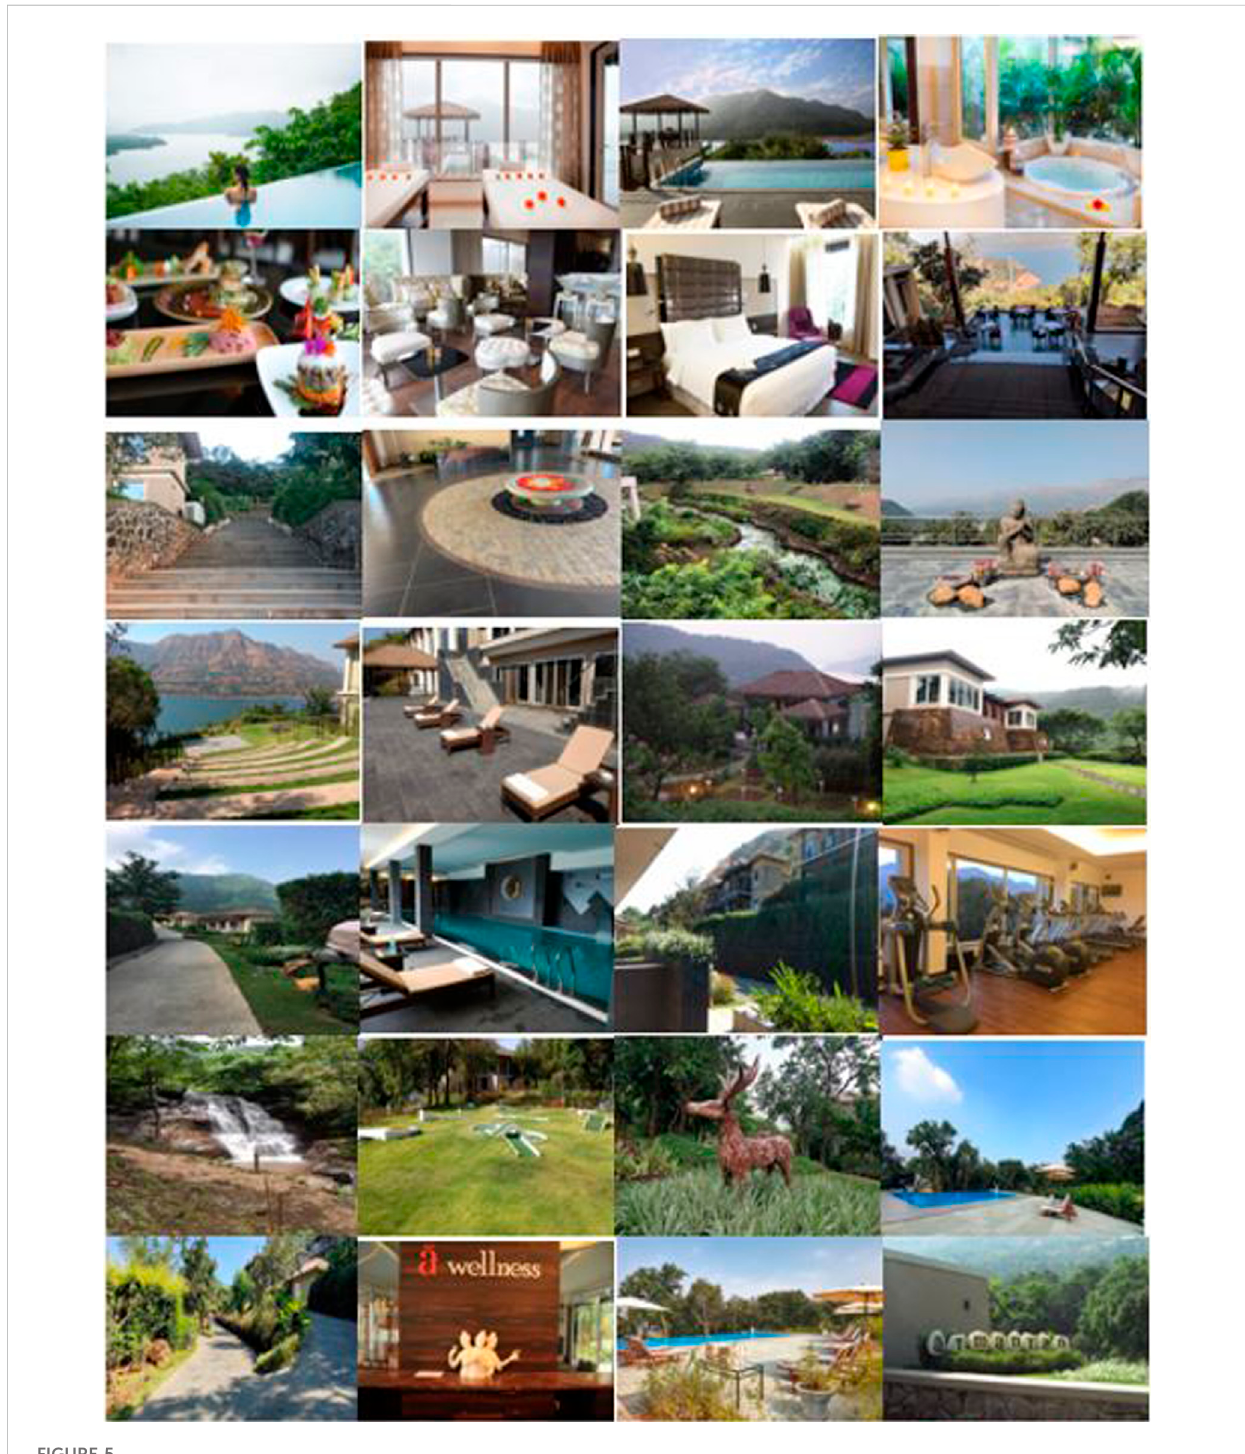
FIGURE 5 Photoproduction of Atmantan Wellness Centre, India; Source: Ekhaese and Ndimako (2022).